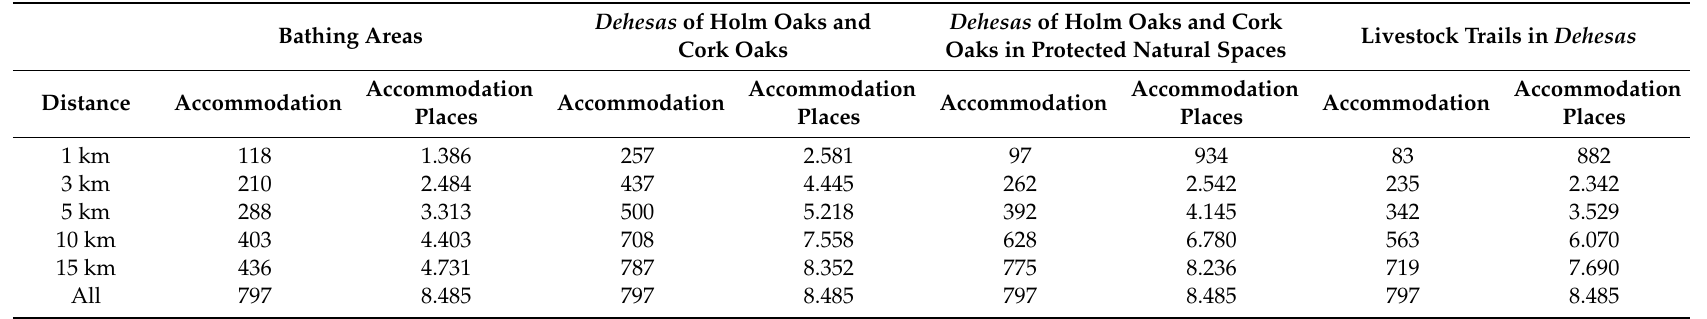
Table 5. Supply of rural establishments according to distances to